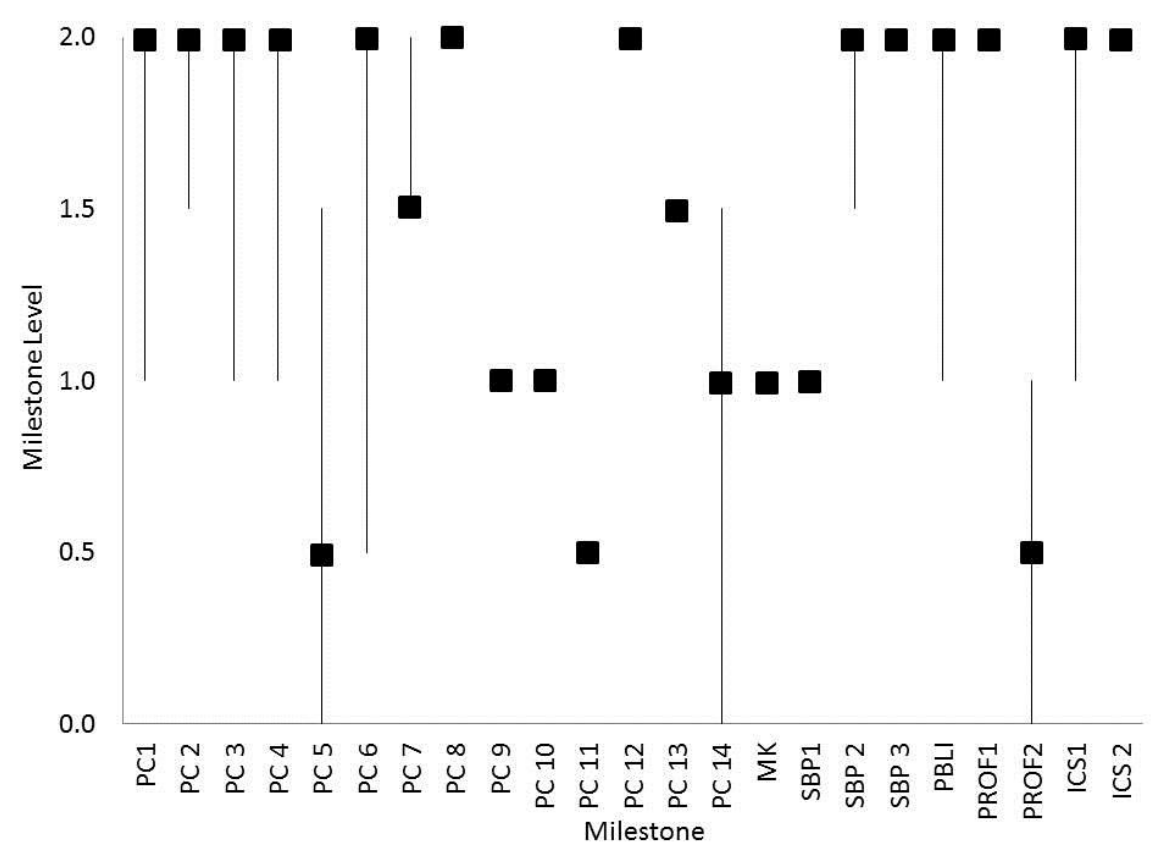
Figure. Median plot of milestone levels attained by 17 medical students who participated in a longitudinal emergency medicine clinical track (a series of required clerkships and electives) during their fourth year of medical